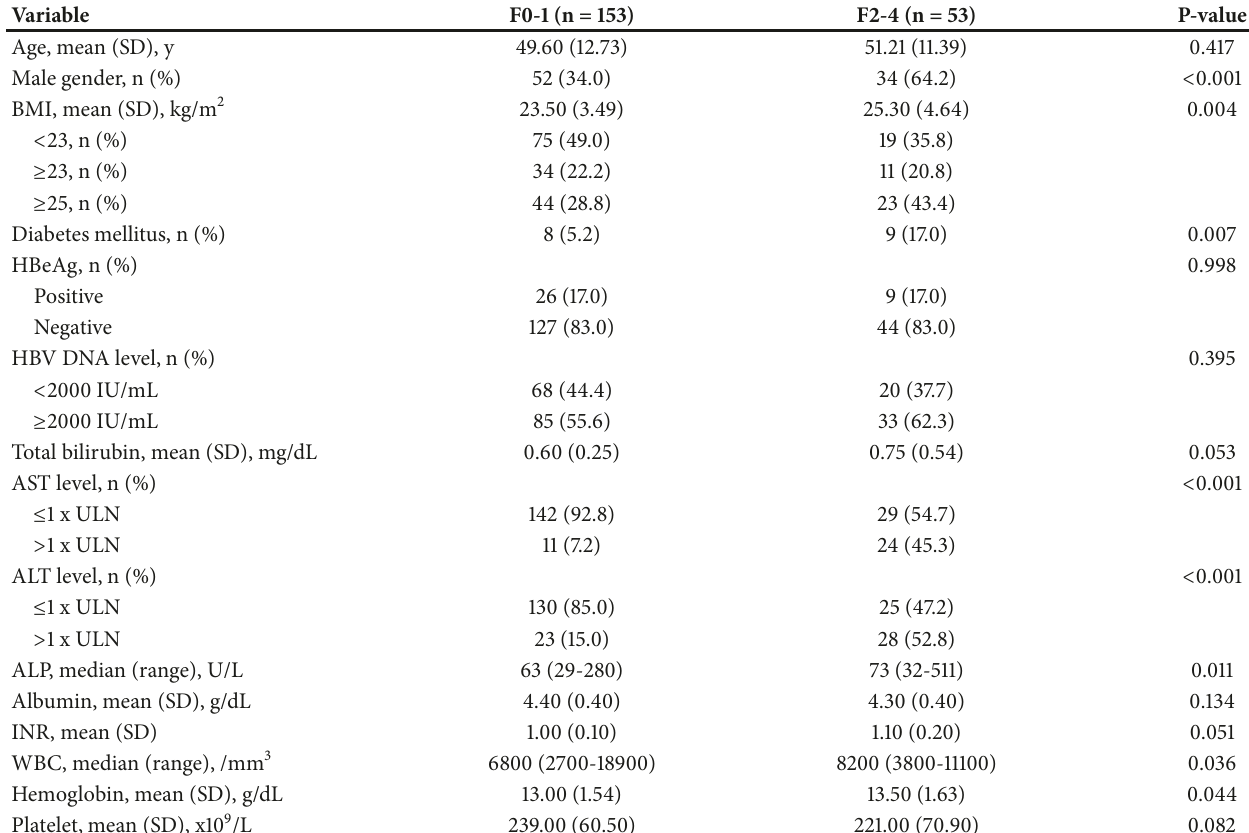
Table 3: Comparison of the baseline characteristics of patients with minimal fibrosis (F0-1) and significant fibrosis (F2-4).